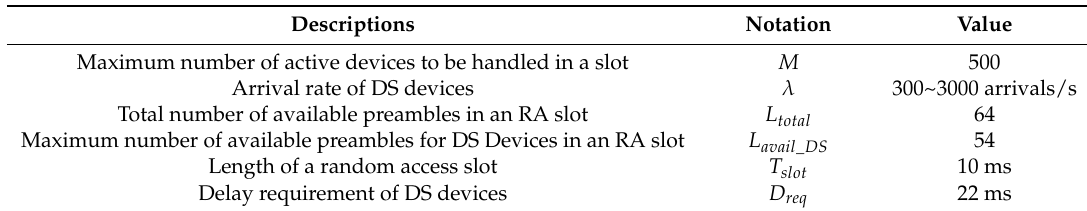
Table 2. Parameters used in performance